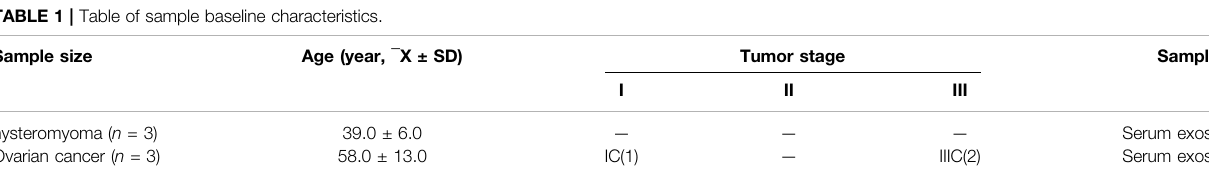
TABLE 1 | Table of sample baseline characteristics.